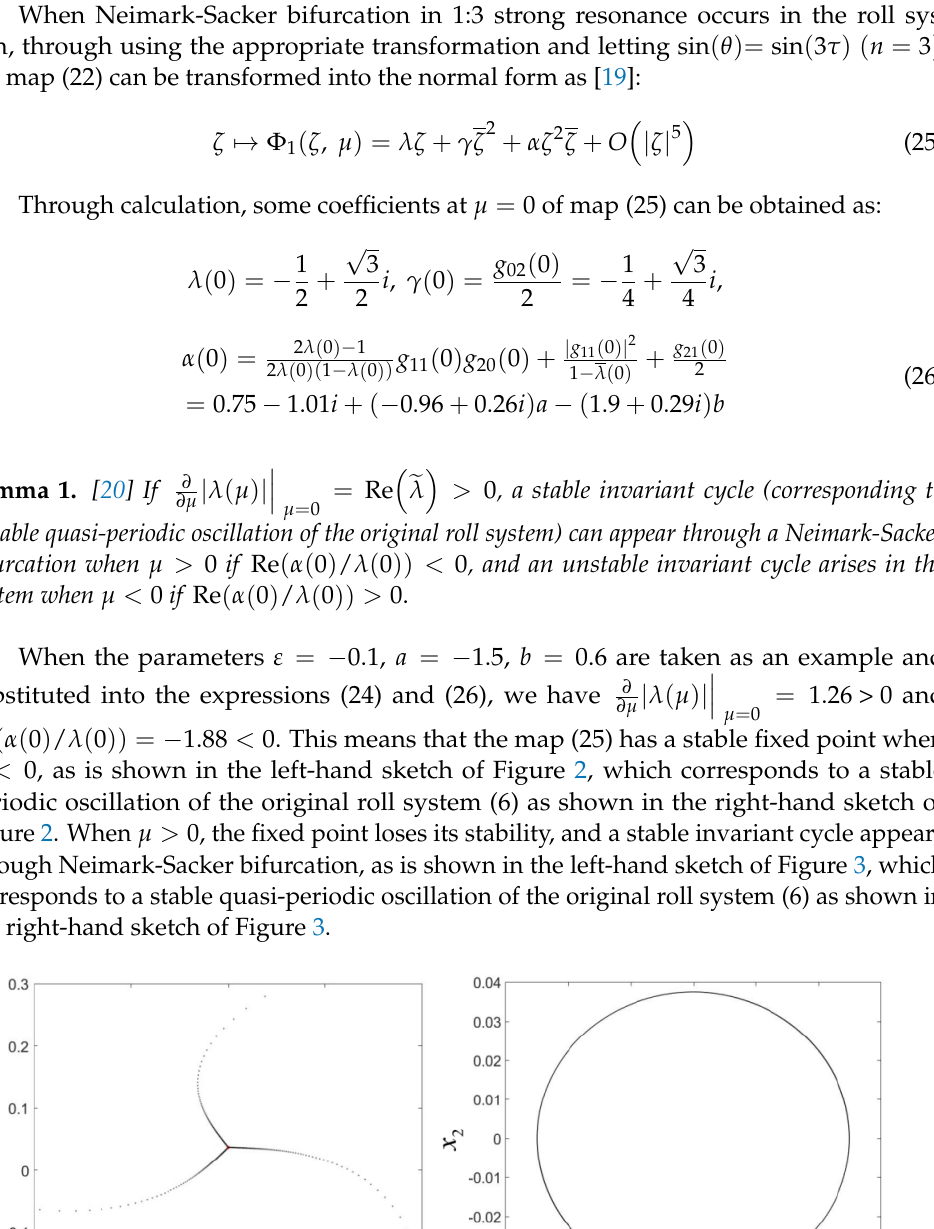
Figure 2. The stable periodic motion in 1:3 resonance when µ = − 0.01: ( left ) the stable fixed point; ( right ) the stable periodic motion.